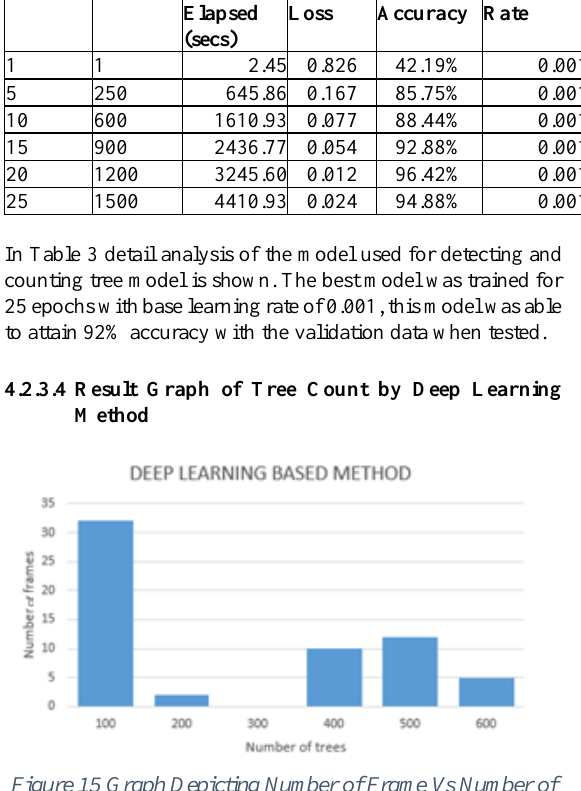
Figure 15 Graph Depicting Number of Frame Vs Number of Trees Counted Through Deep Learning Method on 60